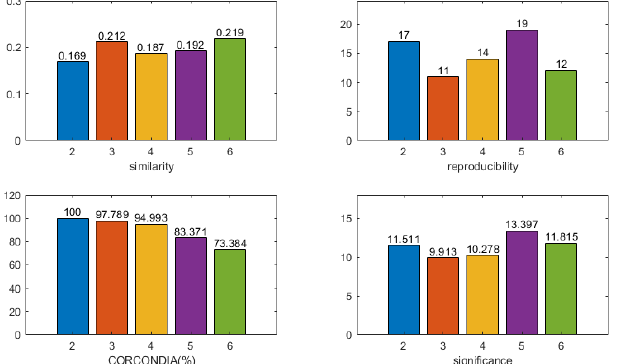
Figure 10. The four indicators of the CMTF model of different numbers of components for subject 1 were calculated. According to the model selection guidelines, a component number of 5 was chosen to analyze the CMTF results for this subject.